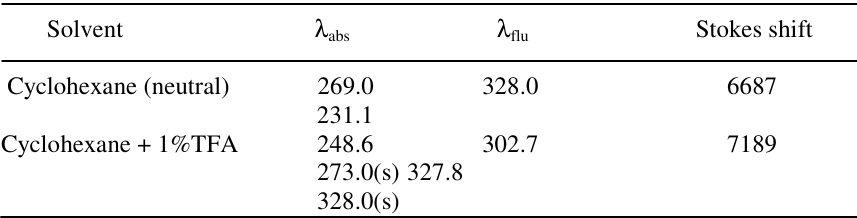
Table 3 . Absorption and fluorescence maxima (nm) and Stokes shift (cm -1 ) of DAAQ in Cyclohexane in presence of